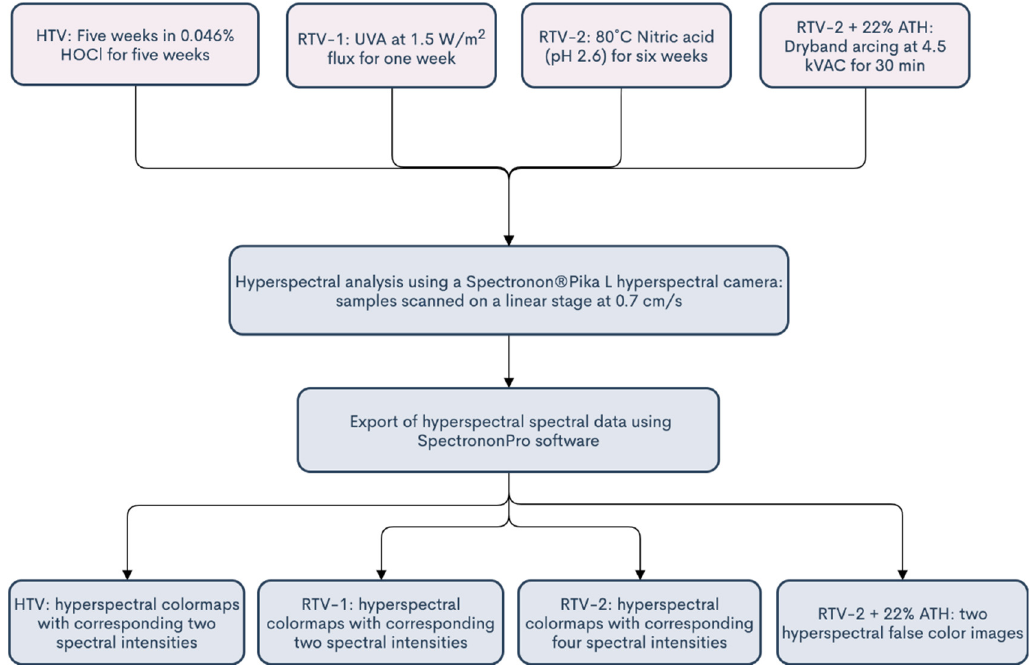
Figure 2. Hyperspectral camera setup, including halogen lighting system and linear stage.